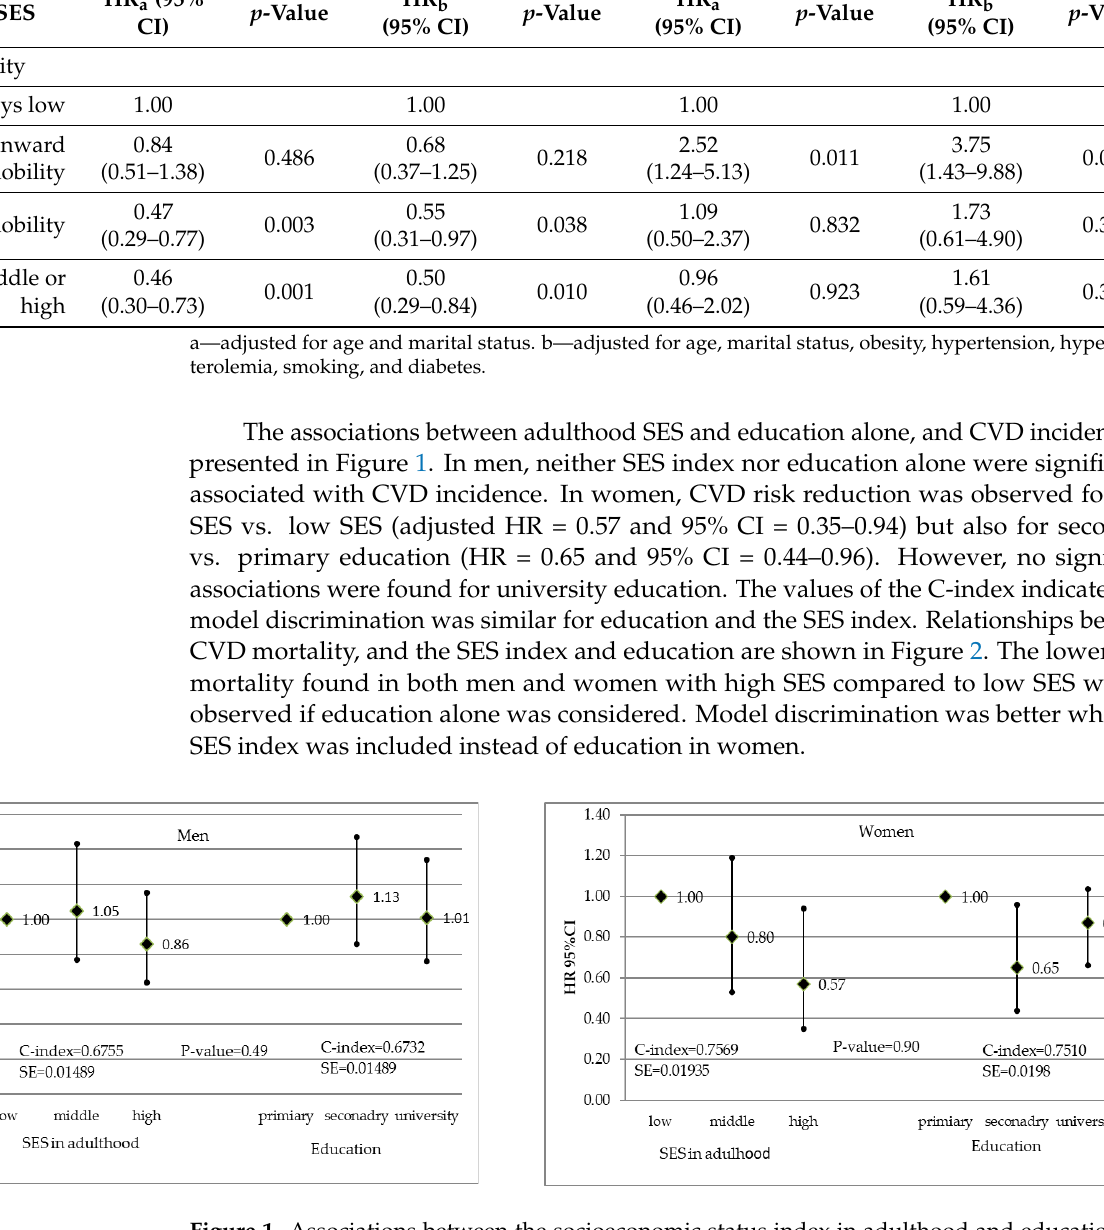
Figure 1. Associations between the socioeconomic status index in adulthood and education, and cardiovascular disease incidence in men and women. Hazard ratios adjusted for age, marital status, obesity, hypertension, hypercholesterolemia, smoking, and diabetes.